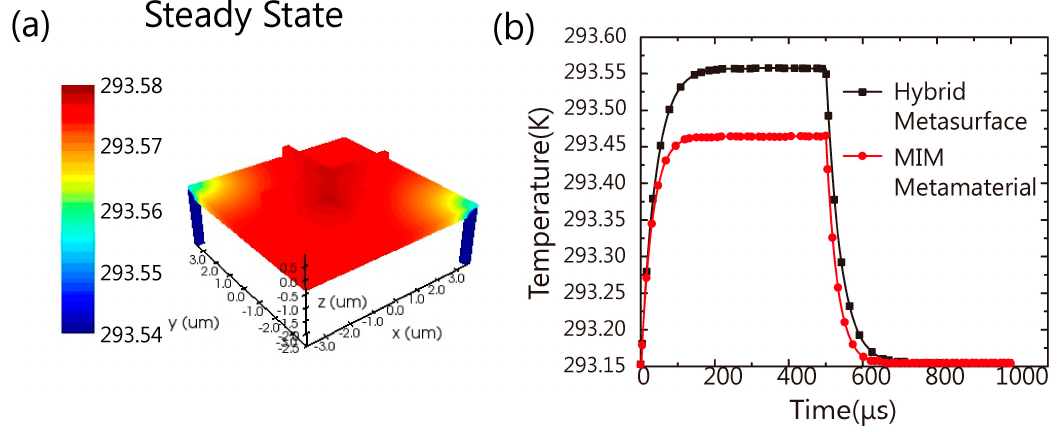
Figure 5. ( a ) The steady-state thermal distribution of the hybrid dielectric metasurface absorber. The power density of the input infrared light is 0.8415 W/cm 2 (0.473 μ w per unit cell). The environmental temperature is 293.15 K, and in order to show the temperature distribution on the metasurface clearly, the lower limit is set to 293.54 K, and the average temperature increase is 0.4 K; ( b ) transient temperature response of the hybrid metasurface absorber and MIM metamaterial bolometer. The input pulse starts from 1 μ s to 500 μ s. The power density is 0.8415 W/cm 2.